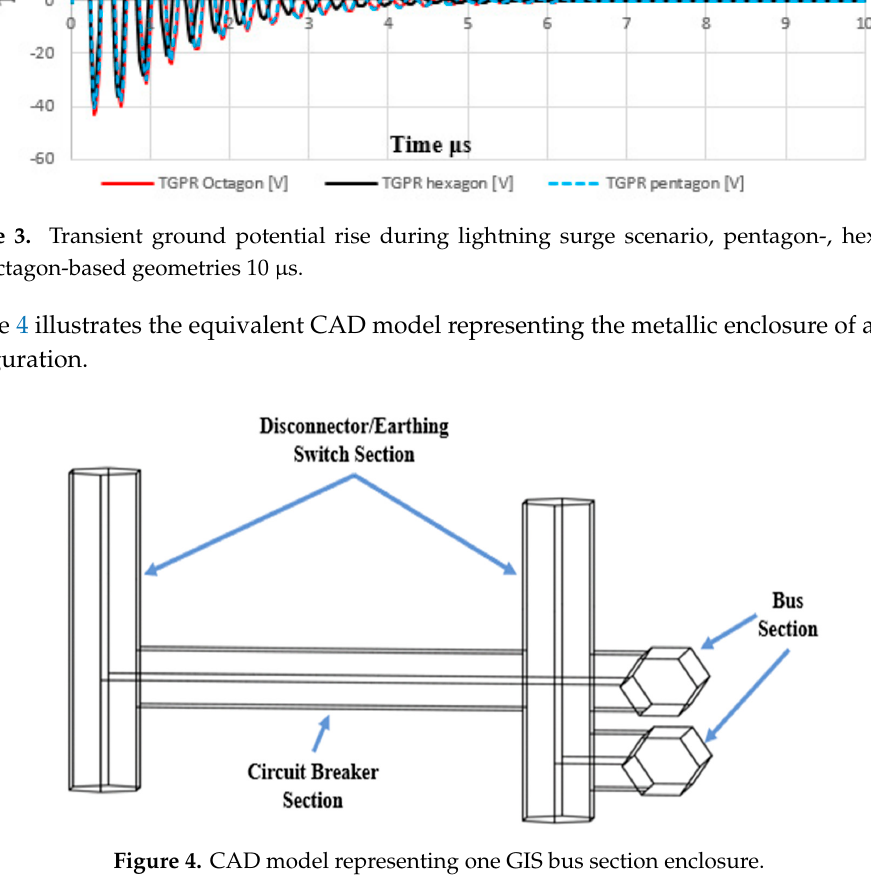
Figure 4. CAD model representing one GIS bus section enclosure.